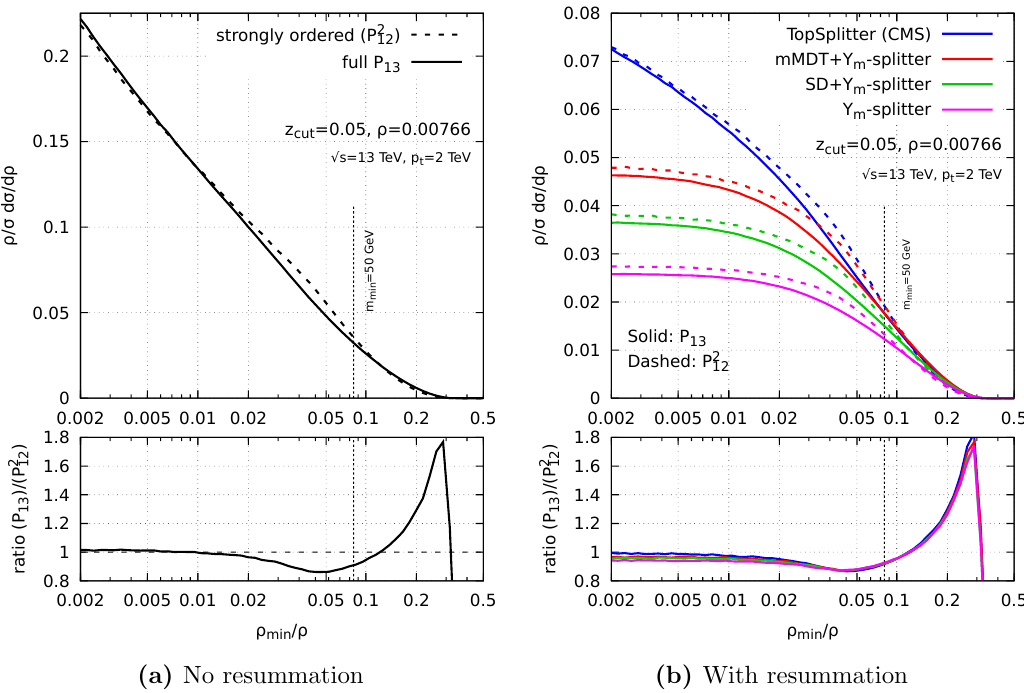
Figure 4. Comparison of the results obtained for quark jets in the strongly-ordered limit (dashed curves) with the results using the full triple-collinear splitting function (solid curves), (a) without including resummation e(cid:11)ects, (b) including resummation e(cid:11)ects. In both cases, the top panel shows the distributions (cid:26)=(cid:27) d(cid:27)=d(cid:26) and the lower panel shows the ratio between the results including the full triple-collinear splitting and the strongly-ordered